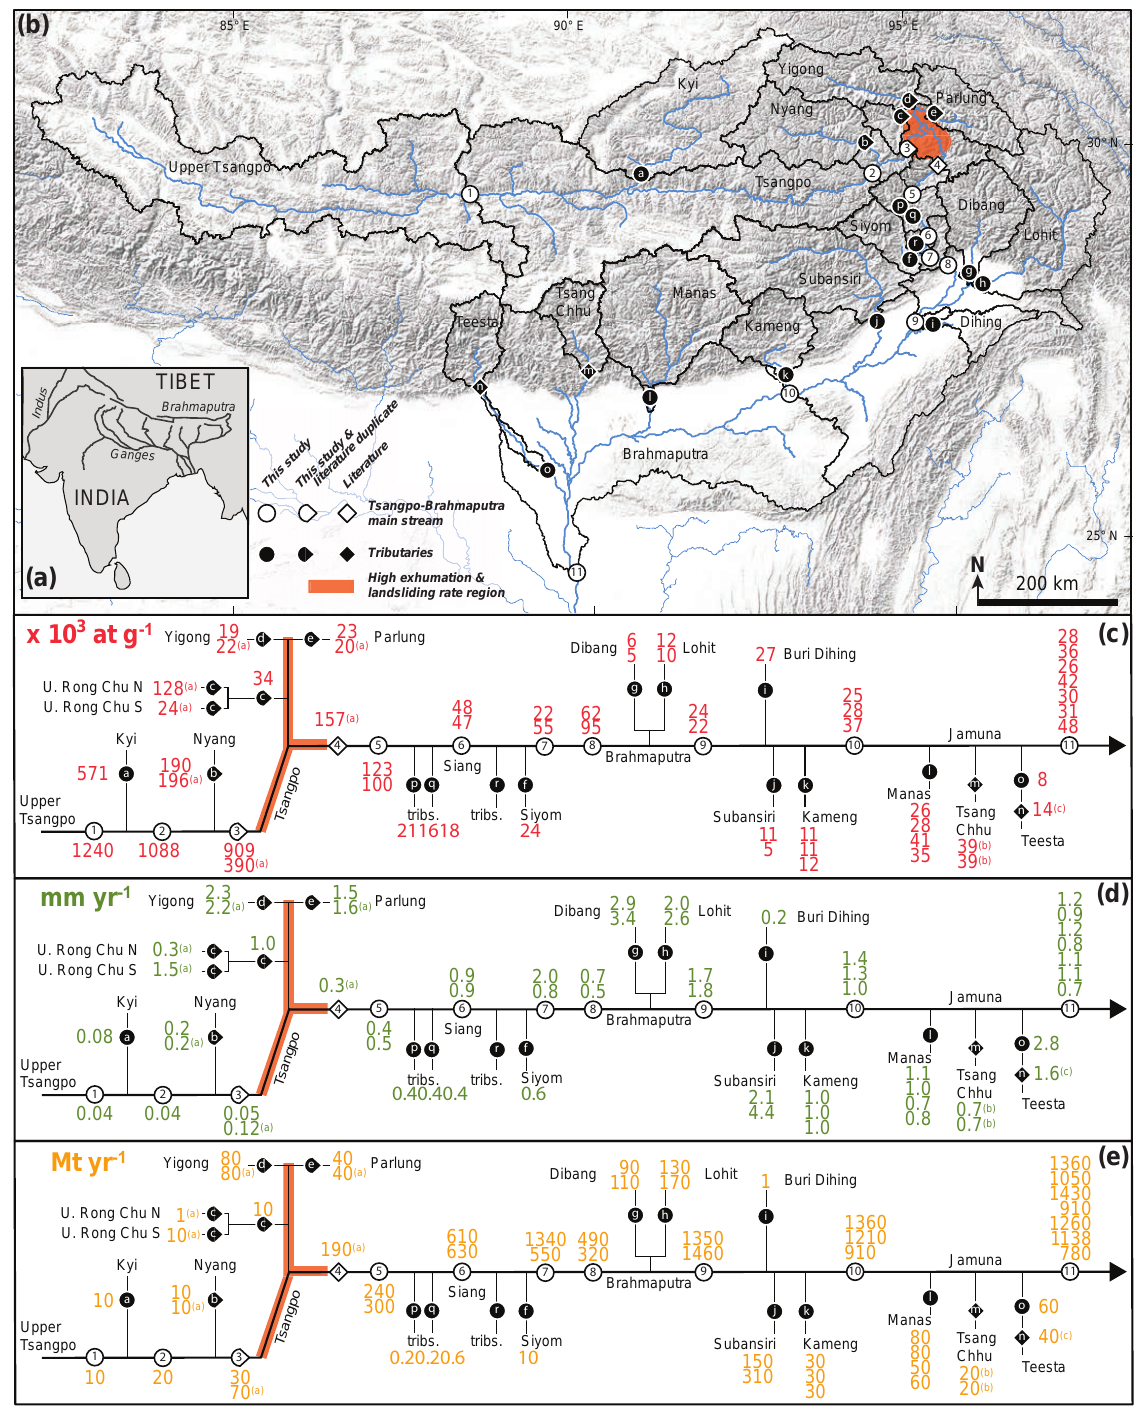
Figure 1. (a) Overview of the study area. (b) Shaded-relief map of the Tsangpo-Brahmaputra map with sampling locations of the trunk stream (open symbols) and main tributaries (filled symbols). The NBGPm area characterized by high erosion and fluvial incision rates (>3mmyr − 1 ) is highlighted in red (see text for references). 10 Be concentrations (c) ; 10 Be-derived denudation rates (d) ; 10 Be-derived sediment fluxes (e) of Tsangpo-Brahmaputra main stream and tributaries. Downstream samples have been corrected for floodplain area by excluding areas below 300ma.s.l. from the calculation. Literature data from Finnegan et al. (2008) (a) , Portenga et al. (2015) (b) , and Abrahami et al. (2016) (c) are also